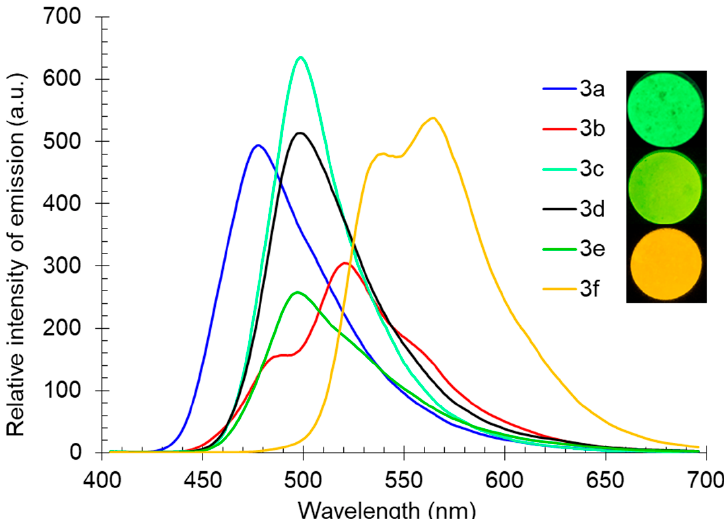
Figure 6. Solid-state photoluminescence spectra of compound 3 in a powder. Photos of compounds 3c , 3e, and 3f were taken under 365 nm of irradiation.